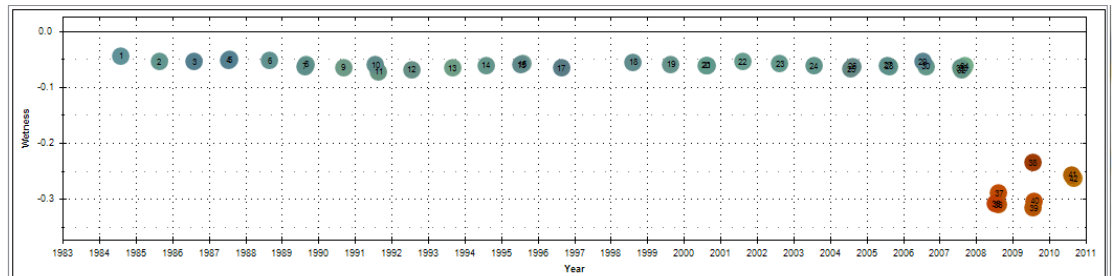
Figure 3. Spectral trajectory of an area of pixels from the center of the landscape change patch in Figure 2. Colors of circles correspond to the tasseled-cap wetness index [16]; see Figure 4 for interpretation of colors.